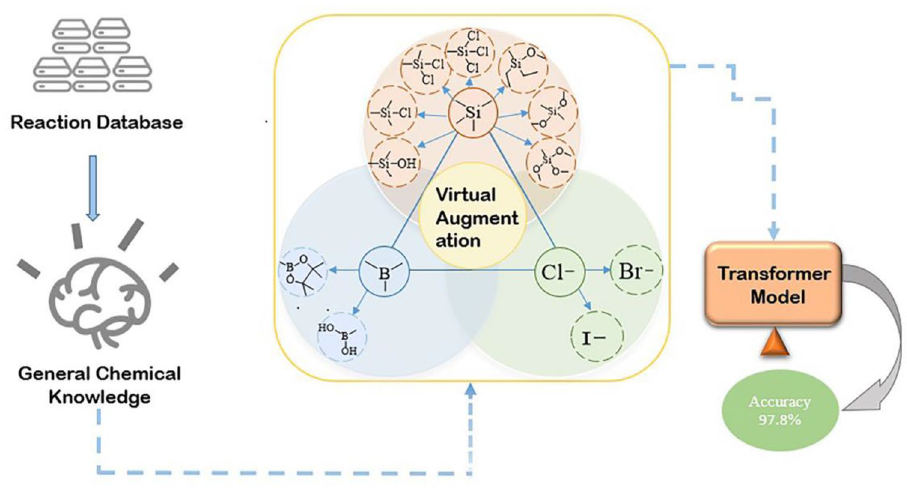
Figure 1. Schematic illustration of the virtual data augmentation